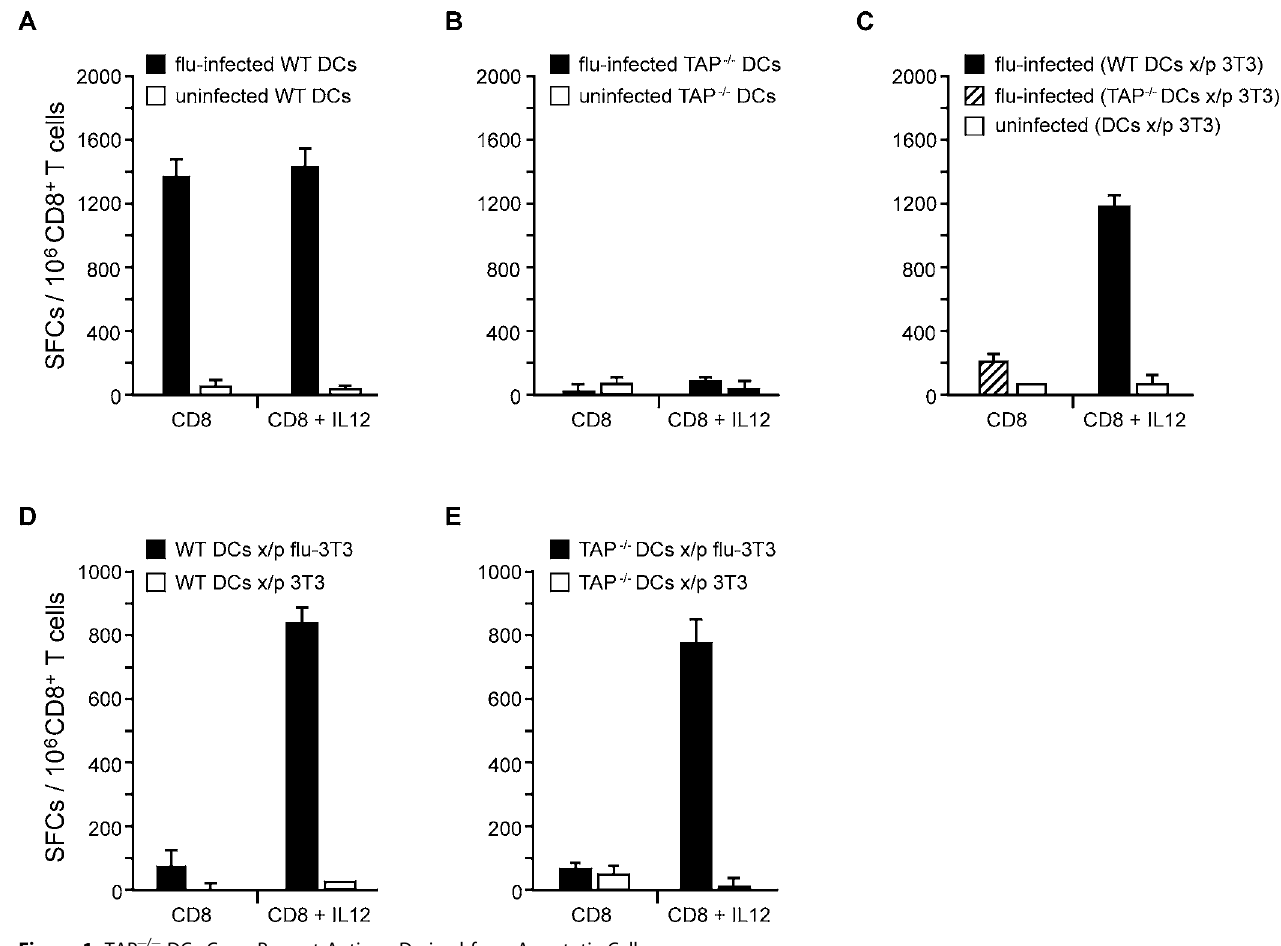
Figure 1. TAP (cid:1) / (cid:1) DCs Cross-Present Antigen Derived from Apoptotic Cells (A and B) Antigen presentation via the endogenous pathway was evaluated in WT DCs and TAP (cid:1) / (cid:1) DCs by directly infecting cells with influenza virus and assaying for T cell activation. IFN- c production and T cell precursor frequency were determined using an ELISPOT assay. (C) To evaluate transfer of TAP activity from the dying cells to DCs, WT or TAP (cid:1) / (cid:1) DCs after capture of apoptotic cells were directly infected and tested for their respective ability to activate CD8 þ T cells via the endogenous pathway. (D and E) WT DCs (D) or TAP (cid:1) / (cid:1) DCs (E) were co-cultured for 36–48 h with influenza-infected or uninfected allogeneic cells in the presence of TNF- a . As above, mature DCs were harvested and assayed for their ability to stimulate influenza-reactive CD8 þ T cells. To bypass the requirement for CD4 þ T cell help in the activation of CD8 þ T cells via the exogenous pathway, IL-12 was added to the cultures. Spot-formingcells(SFCs)per10 6 Tcellsarereported.Dataarerepresentativeofthreeexperiments.Valuesareaveragesoftriplicatewellswitherror bars indicating standard deviation. DOI: